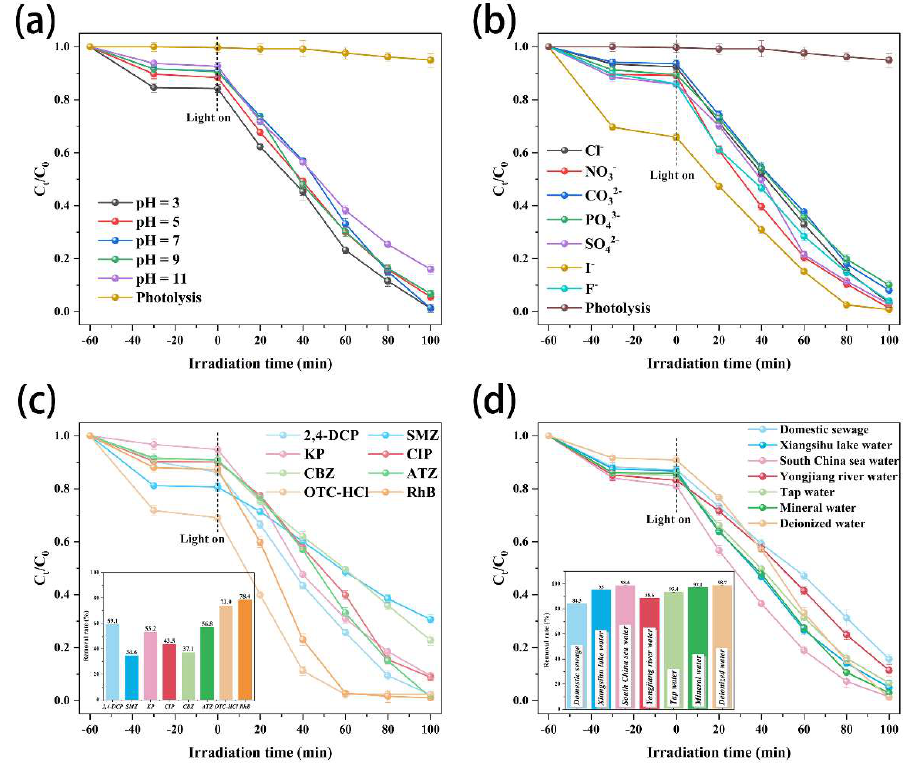
Figure 8. ( a ) Photocatalytic removal performance tests for ATZ by different pH and ( b ) solution containing different anions, ( c ) Photocatalytic activities of 2BBOS for 2,4-DCP, SMZ, KP, CIP, CBZ, ATZ, OTC-HCl, and RhB removal rate. ( d ) Photocatalytic removal performance tests for ATZ in different water environment.